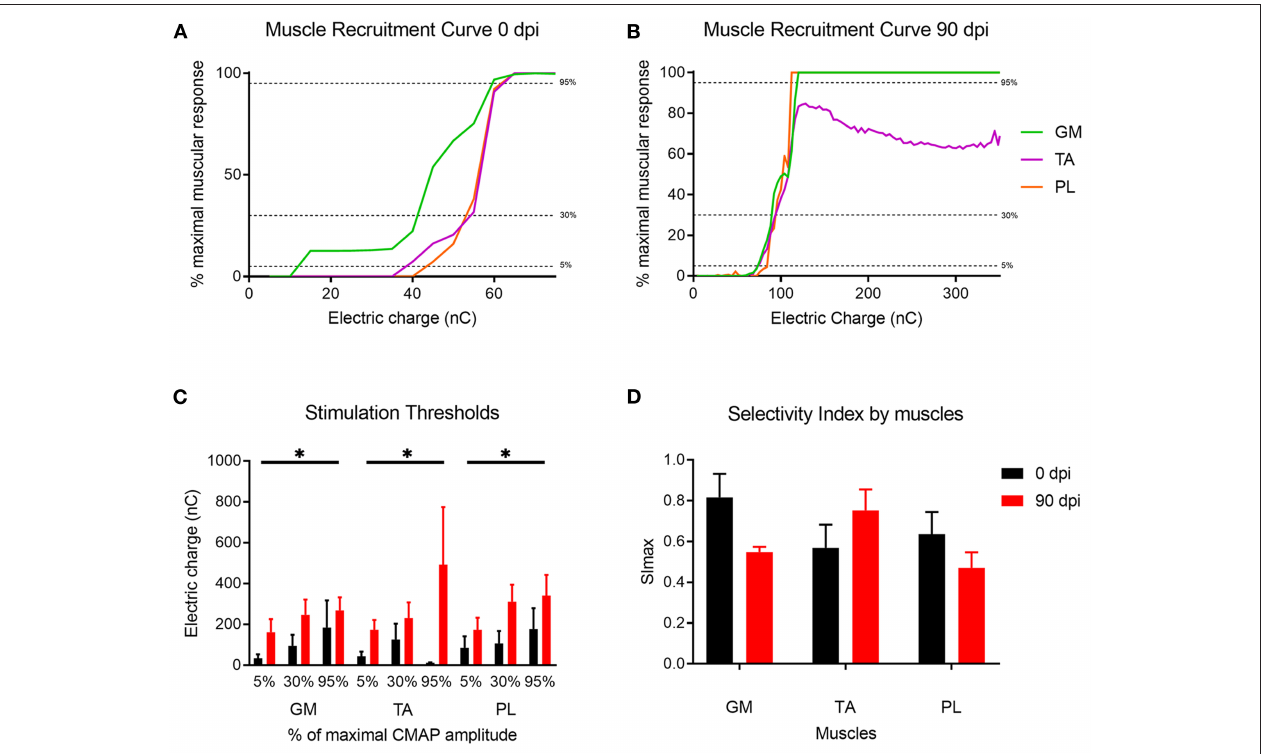
FIGURE 6 | Muscle recruitment curves. (A,B) Representative muscle recruitment curves from selected active sites at (A) 0 dpi and (B) 90 dpi. The increase of the electrical charge delivered through the device elicited recruitment of more muscular fibers thus increasing the CMAP amplitude. (C) Values of the electrical charge needed to elicit 5, 30, and 95% of the maximum CMAP amplitude of gastrocnemius (GM), tibialis anterior (TA) and plantar interossei muscles (PL). (D) Maximal selectivity index (SImax) for GM, TA, and PL muscles over time. * p < 0.05 vs.